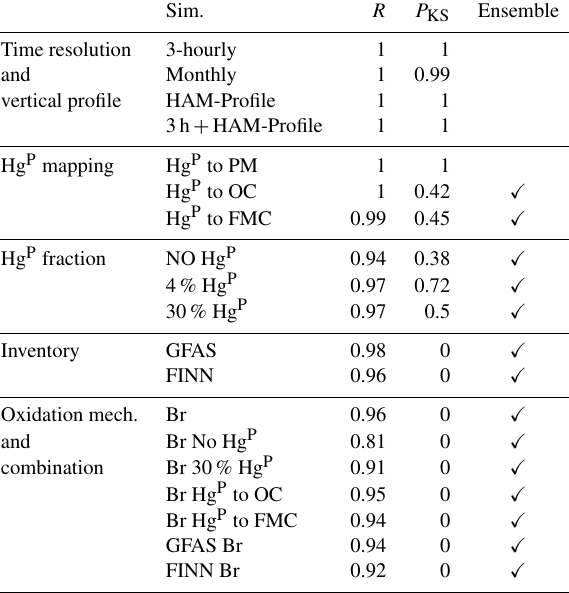
Table 3. Horizontal pattern correlation ( R ) and probabilities that the Hg deposition fields of the different runs belong to the same distribution as the BASE run ( P KS ). The checks in the ensemble column indicate the inclusion of the respective run in the ensemble in Fig. 13.